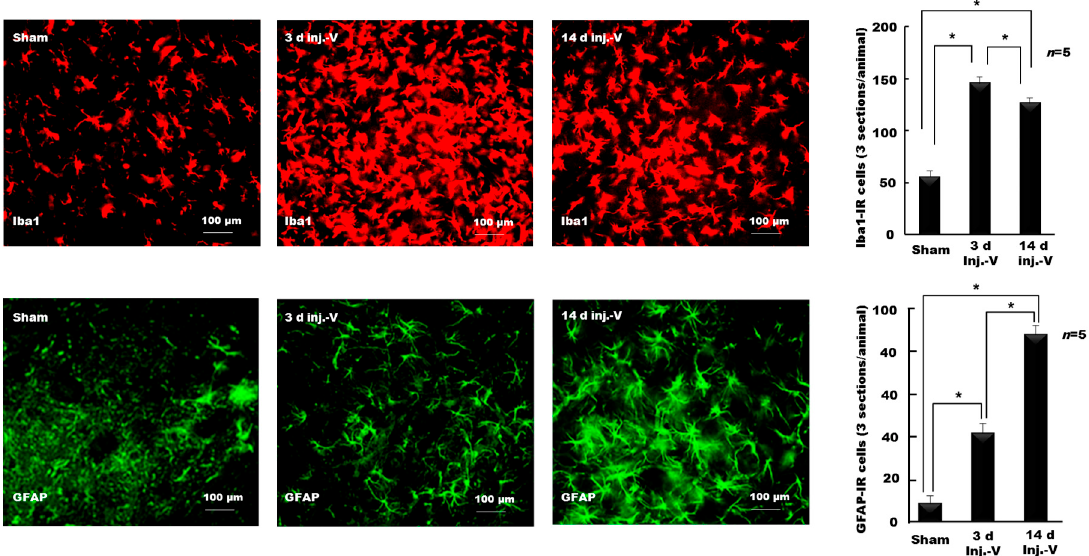
Figure 4. Temporal profile of microglial and astroglial activation in the motor nucleus of the trigeminal nerve following peripheral nerve injury (inj-V: injury to the trigeminal nerve). Following nerve injury, the numbers of activated microglial and astroglial cells (counted on day 3 and 14 following nerve injury) were increased significantly compared with sham-operated rats. The highest number of activated microglia was observed on day 3 following injury; however, the highest number of activated astroglia was observed on day 14 following injury. The figure is modified from our previous published papers [118,119]. * p < 0.05